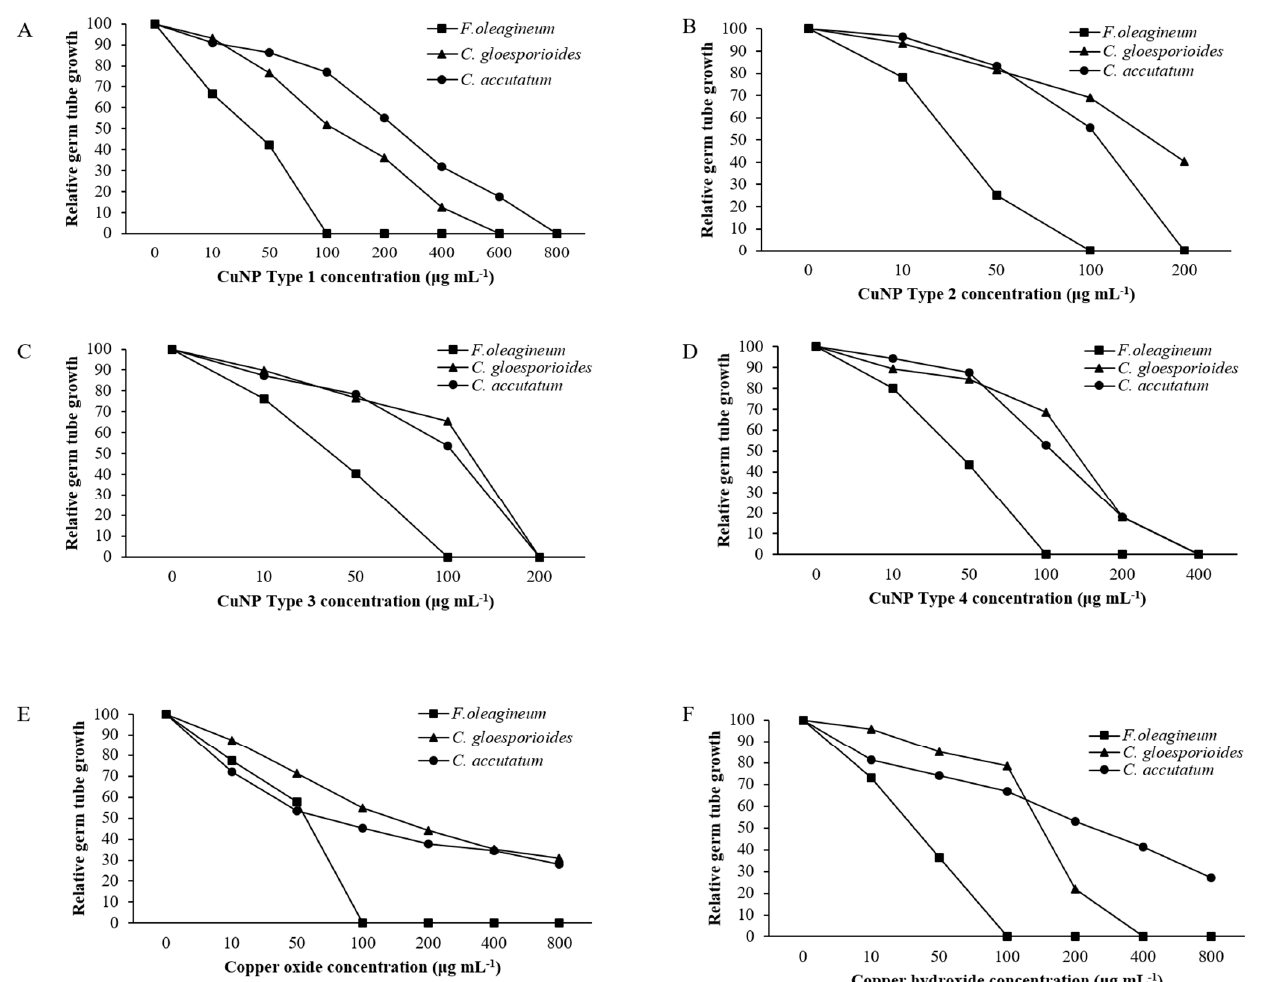
Figure 7. Mean relative germ tube growth of Fusicladium oleagineum , Colletotrichum acutatum s.s., and Colletotrichum gloesporioides s.s. isolates on artificial nutrient media amended with several concentrations of CuNP Type 1 ( A ), CuNP Type 2 ( B ), CuNP Type 3 ( C ), CuNP Type 4 ( D ), Copper oxide ( E ), and Copper hydroxide ( F ).